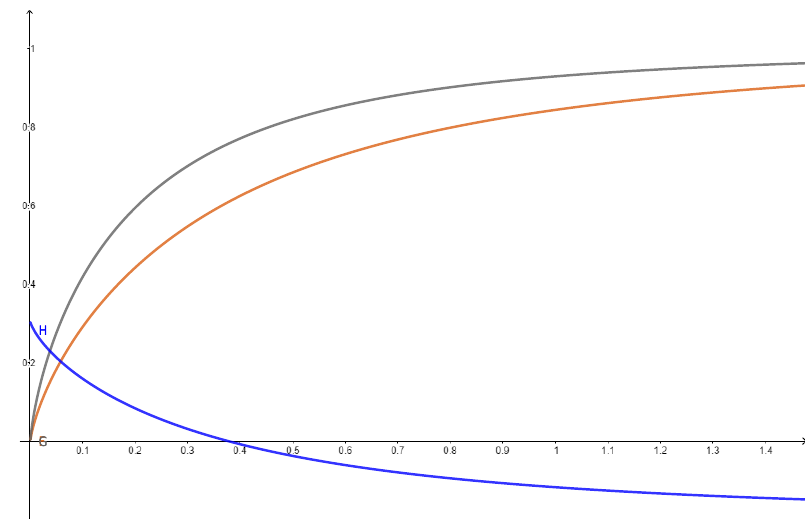
Figure 1. Graphs of the functions F and G (from Remark 1) and H (from Remark